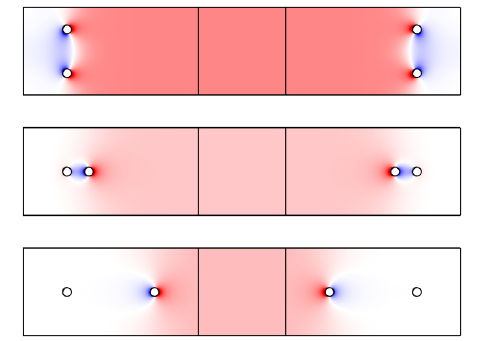
Fig.2: Sensitivity field plots for the three models, starting with model A at the top followed by model B and C. The red regions represent positive sensitivity while the blue regions represent negative sensitivity. The absolute value is higher the stronger the color is.